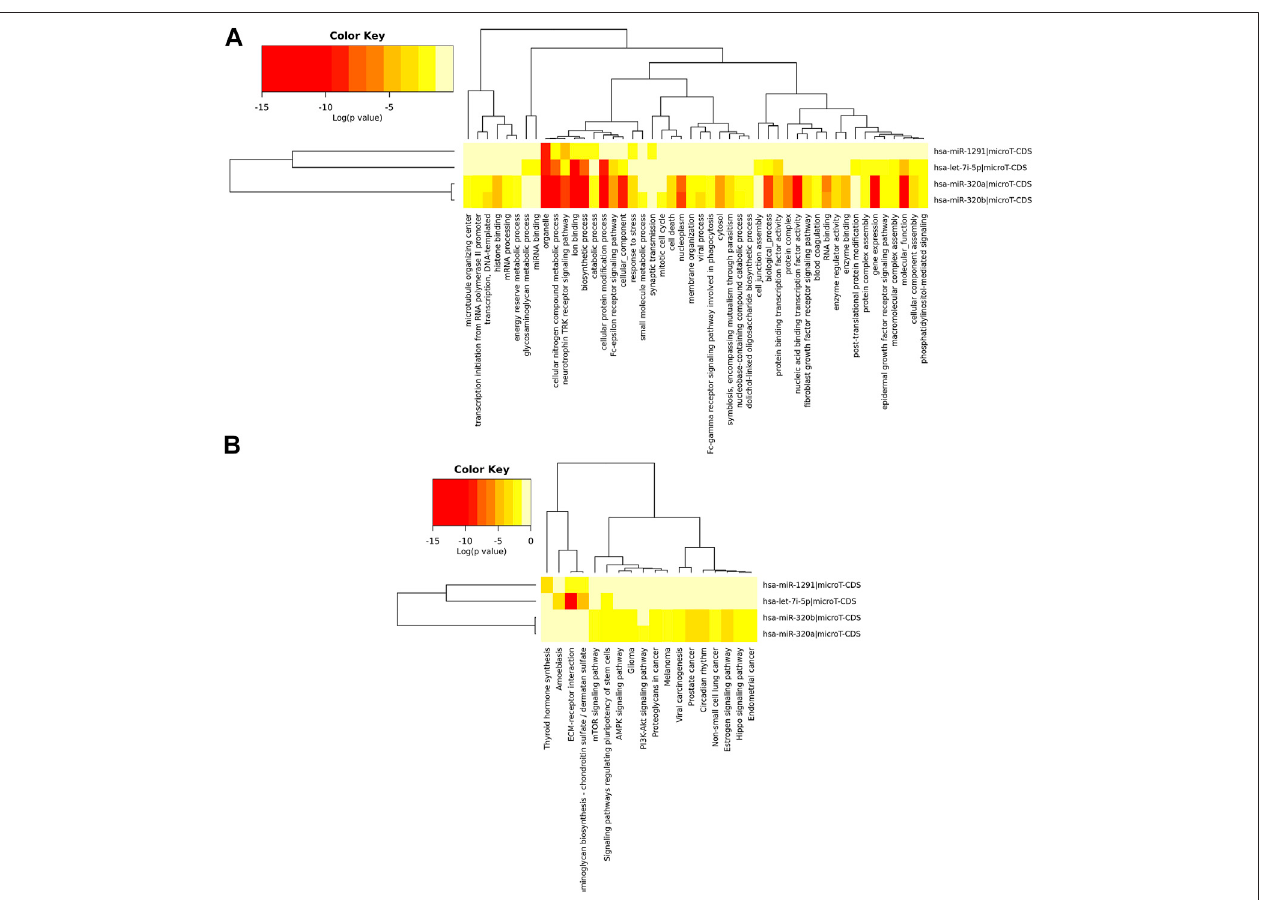
FIGURE4| Hierarchical clustering based onpredictedtarget genesofupregulated miRNAs in APTE samples. (A) Ontology-based hierarchical clustering ofgenes identi fi ed as predicted targets of upregulated miRNAs in APTE. Using mirPath from DIANA tools, the upregulated miRNAs APTE samples were used to prepare a heatmap based on the gene ontology of predicted target genes. (B) Pathways based hierarchical clustering of predicted target genes as part of upregulated miRNAs in APTE samples. Kyoto Encyclopedia of Genes and Genomes (KEGG) based mapping of putative target genes in various pathways as part of the upregulated miRNAs and their canonical target